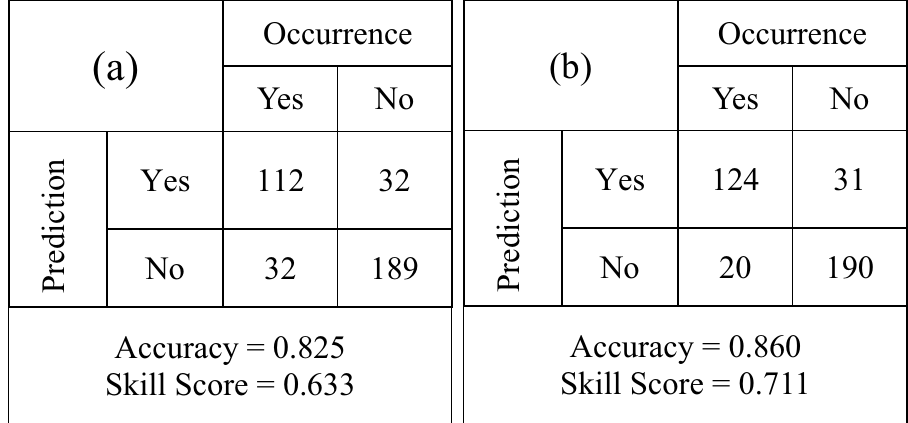
Table 1 Contingency table for the categorical forecast of Es layer